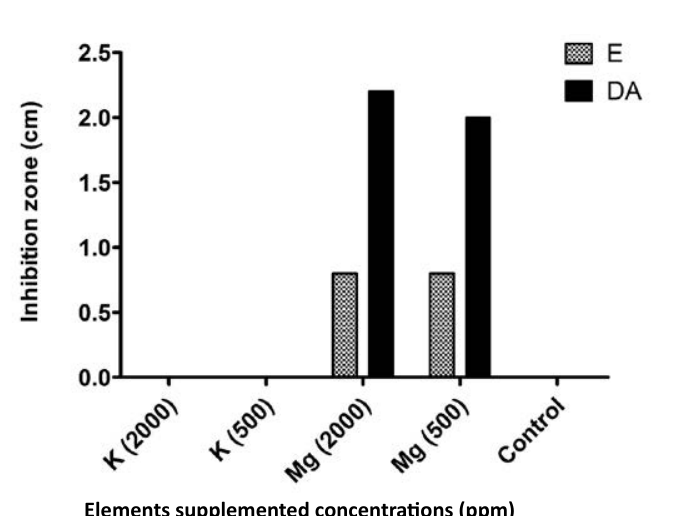
Elements supplemented concentrations Fig. 3. Synergistic effect of potassium (K) and magnesium (Mg) supplementation with antibiotic discs of erythromycin (E) and clindamycin (DA) against MRSA strain (S8).